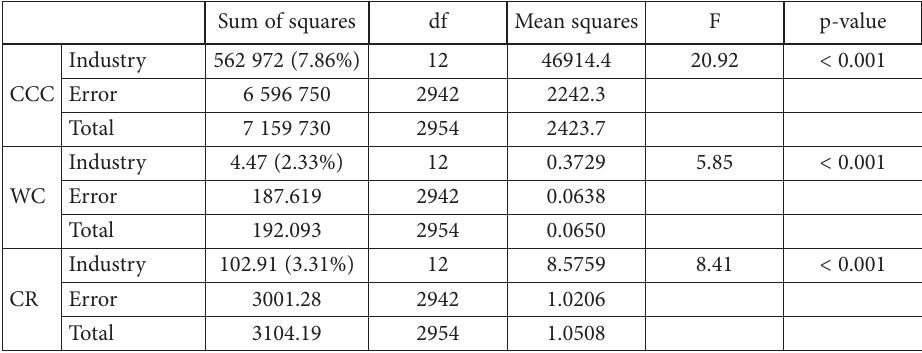
Table 7. Results of ANOVA analysis (industry) (source: own elaboration) Sum of squares df Mean squares F